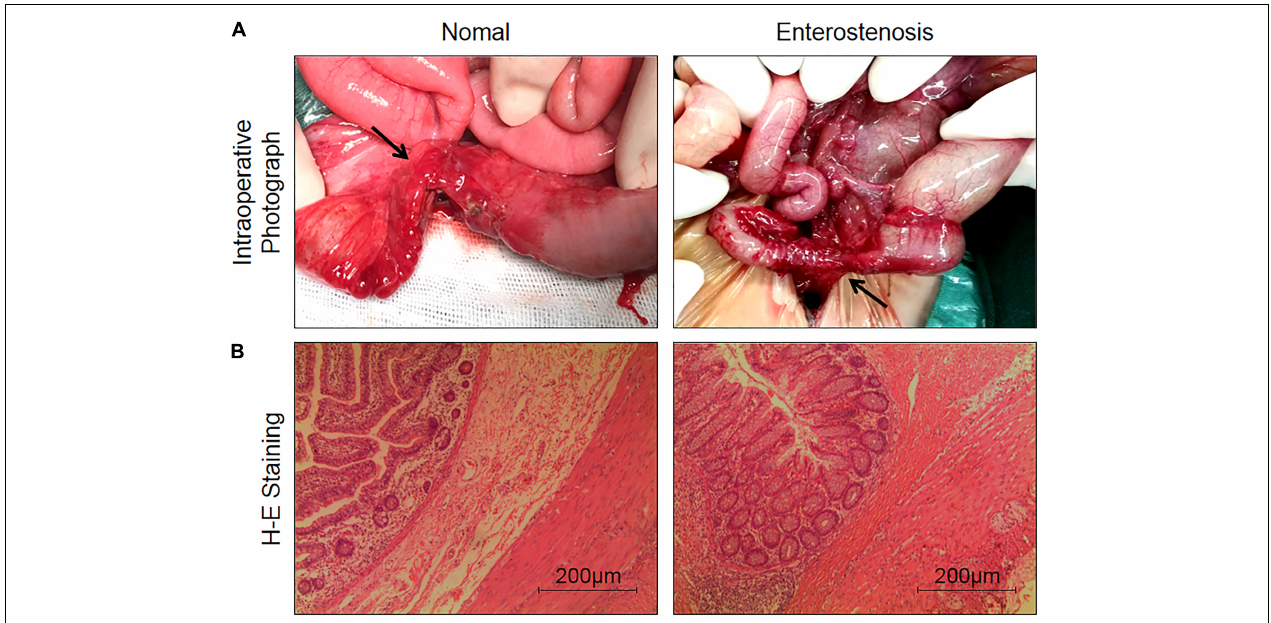
FIGURE 1 | The characteristics of pathological changes in post-necrotizing enterocolitis stricture. (A) Intraoperative photograph of post-necrotizing enterocolitis stricture tissue (the black arrow indicates the intestinal stenosis). (B) Comparison of H and E staining pictures of intestinal normal tissue and post-necrotizing enterocolitis stricture tissue (5 × 10